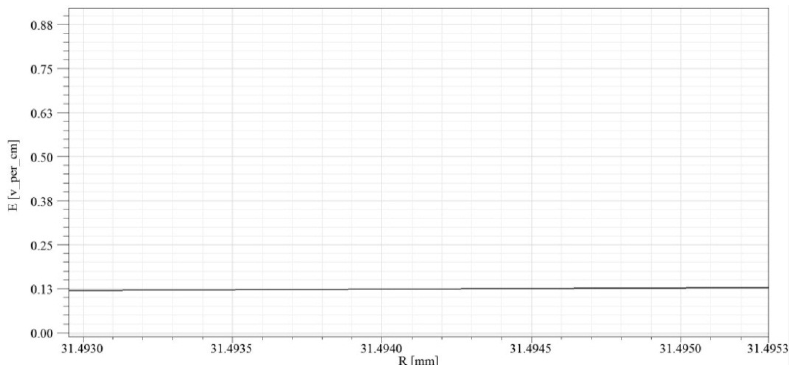
Figure 14. Internal electric field intensity distribution of sensor electrode.